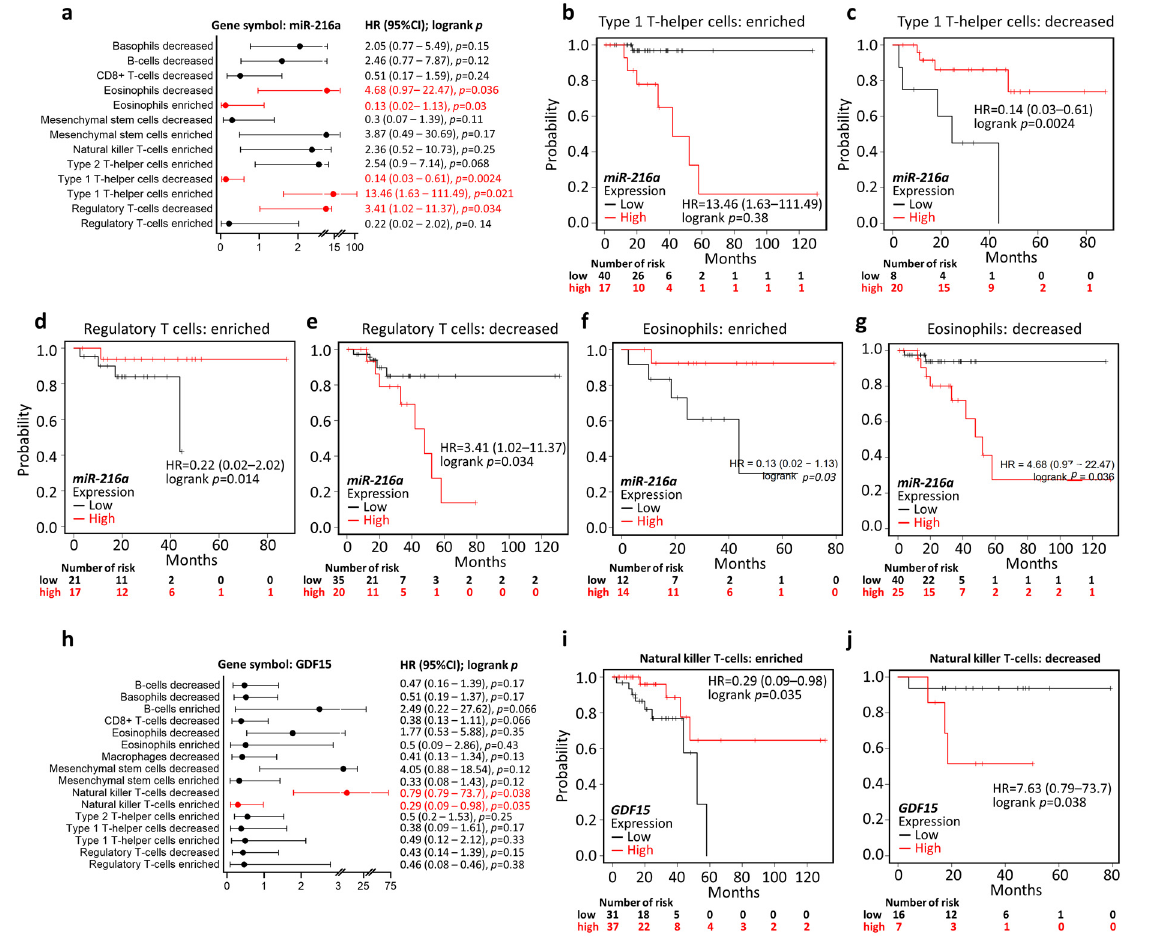
Figure 3. Immune cell contents altered the predictive significance of miR-216a and GDF15 . ( a ) Forest plots summarizing the hazard ratio (HR), the 95% confidence interval (95% CI), and the logrank p -value of COAD miR-216a expression in the context of various immune cell contents. Kaplan–Meier analysis based on low/high miR-216a in the presence of enriched type 1 T-helper (Th1) cells ( b ), decreased Th1 cells ( c ), enriched regulatory T (Treg) cells ( d ), decreased Treg cells ( e ), enriched eosinophils ( f ), and decreased eosinophils ( g ). ( h ) Forest plots summarizing the HR, 95% CI, and logrank p -value of GDF15 expression of COAD in the context of various immune cell contents. Kaplan–Meier analysis based on low/high GDF15 expression in the presence of enriched natural killer T-cells (NKTs) ( i ) and decreased NKTs ( j ).